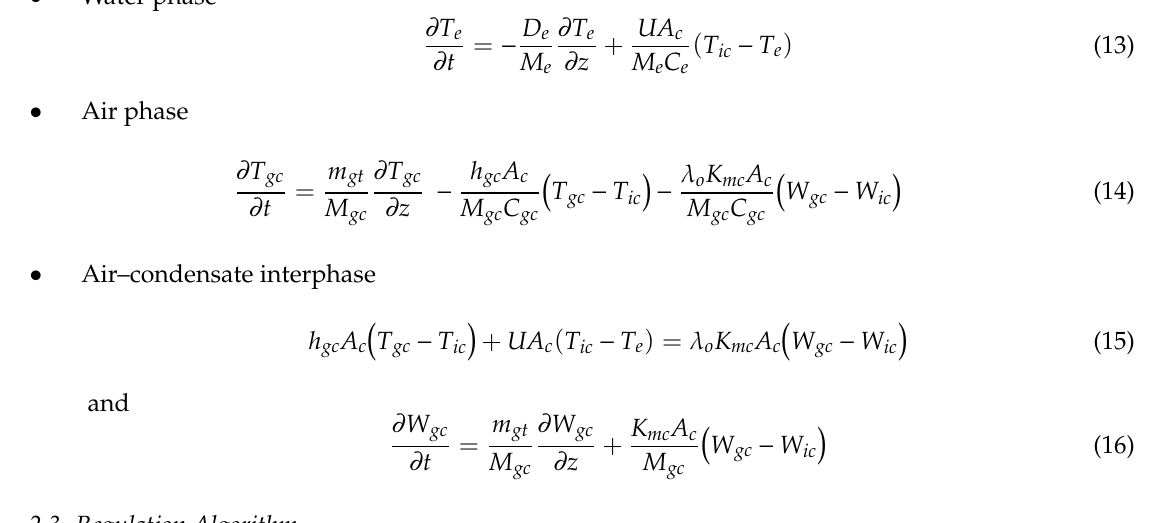
Figure 8. The input / output block diagram of the condensation Figure 8. The input/output block diagram of the condensation tower.